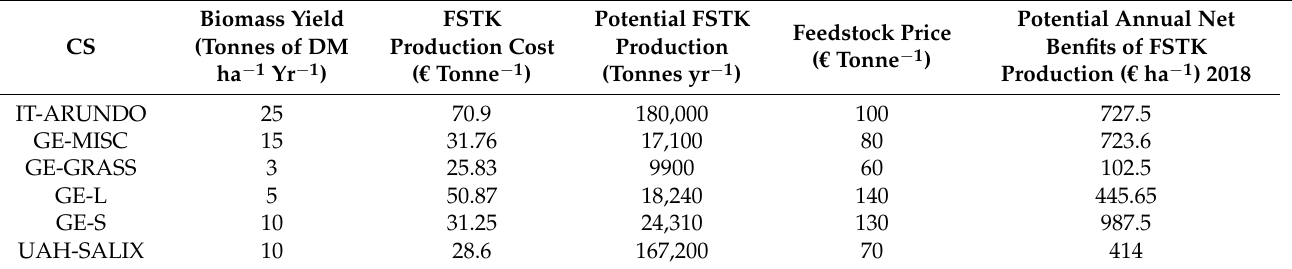
Table 2. Feedstock production and relative cost for the selected investments.